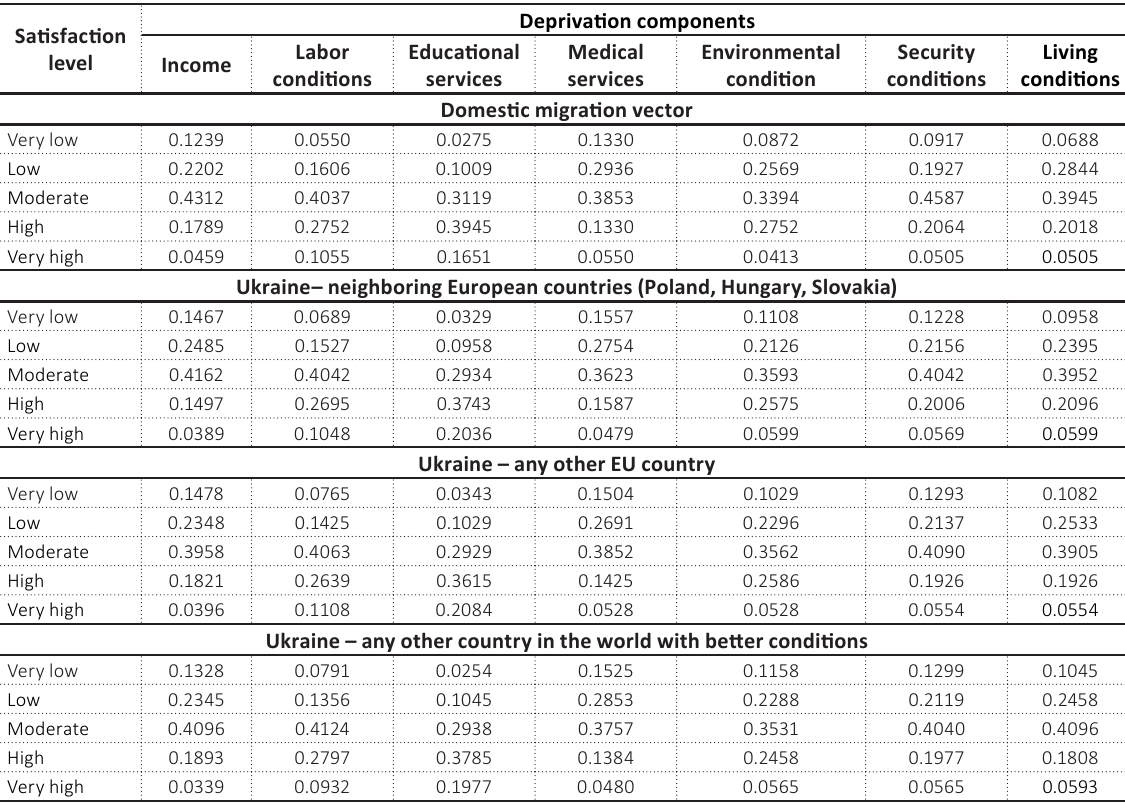
Table 2. Level of positive migration aspirations in the context of deprivation components: outbound migration vectors, Lviv Oblast,